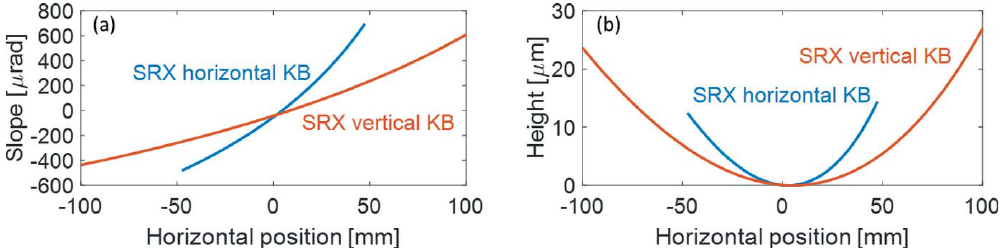
Figure 2 Measurement results of the SRX KB mirrors using the NSP instrument: ( a ) slope profiles, ( b ) height profiles, integrated using the slope